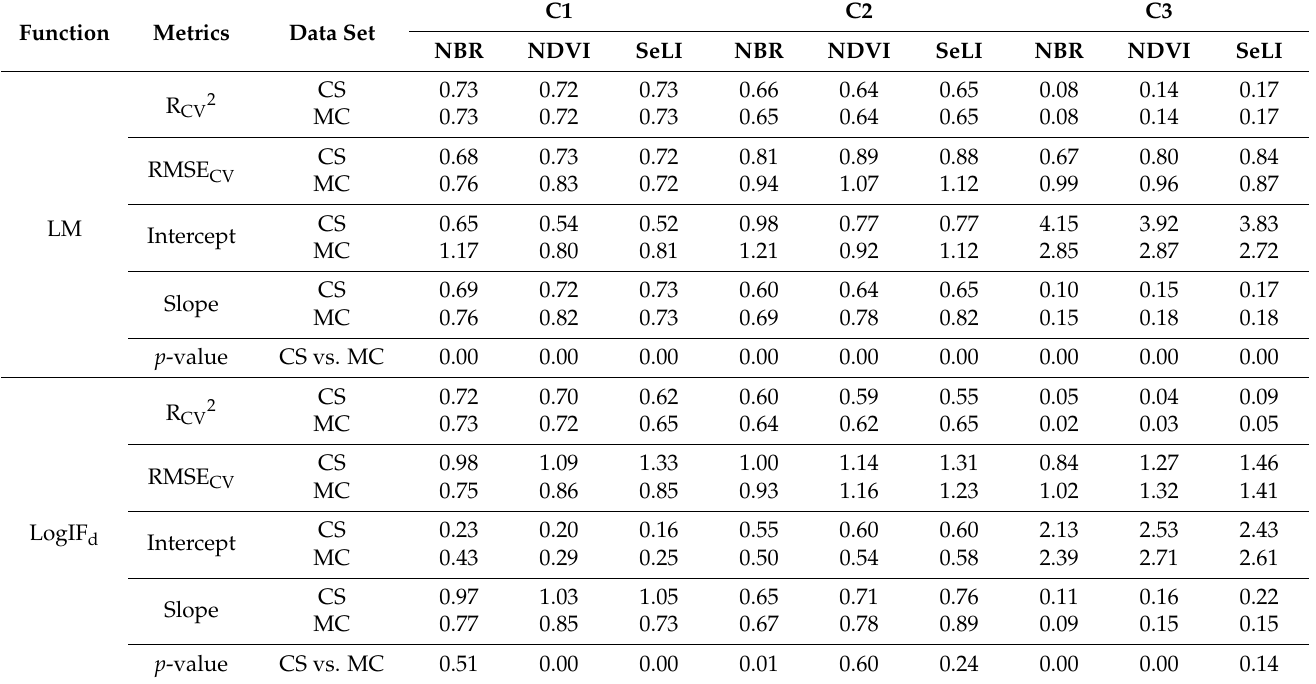
Table 4. Cross-validation results of LAI estimation at pixel level from SeLI, NDVI, and NBR using the linear function (LM) and the inverse function improved with the conditional statement d (LogIF d ). The table reports, for each crop (C1 = winter wheat, C2 = maize, and C3 = alfalfa), the metrics obtained, according to the parameterization made on the crop-specific (CS) and the mixed-crop (MC) data sets. The table reports the mean of coefficient of determination (R 2 CV ) and root mean square error (RMSE CV ) estimated from the k-fold cross validation procedure ( k = 3); as well as the slope and the intercept of regression lines. The p -values < 0.05 (*), <0.01 (**), and <0.001 (***) indicate significant differences between the predicted LAI with MC and CS data sets.